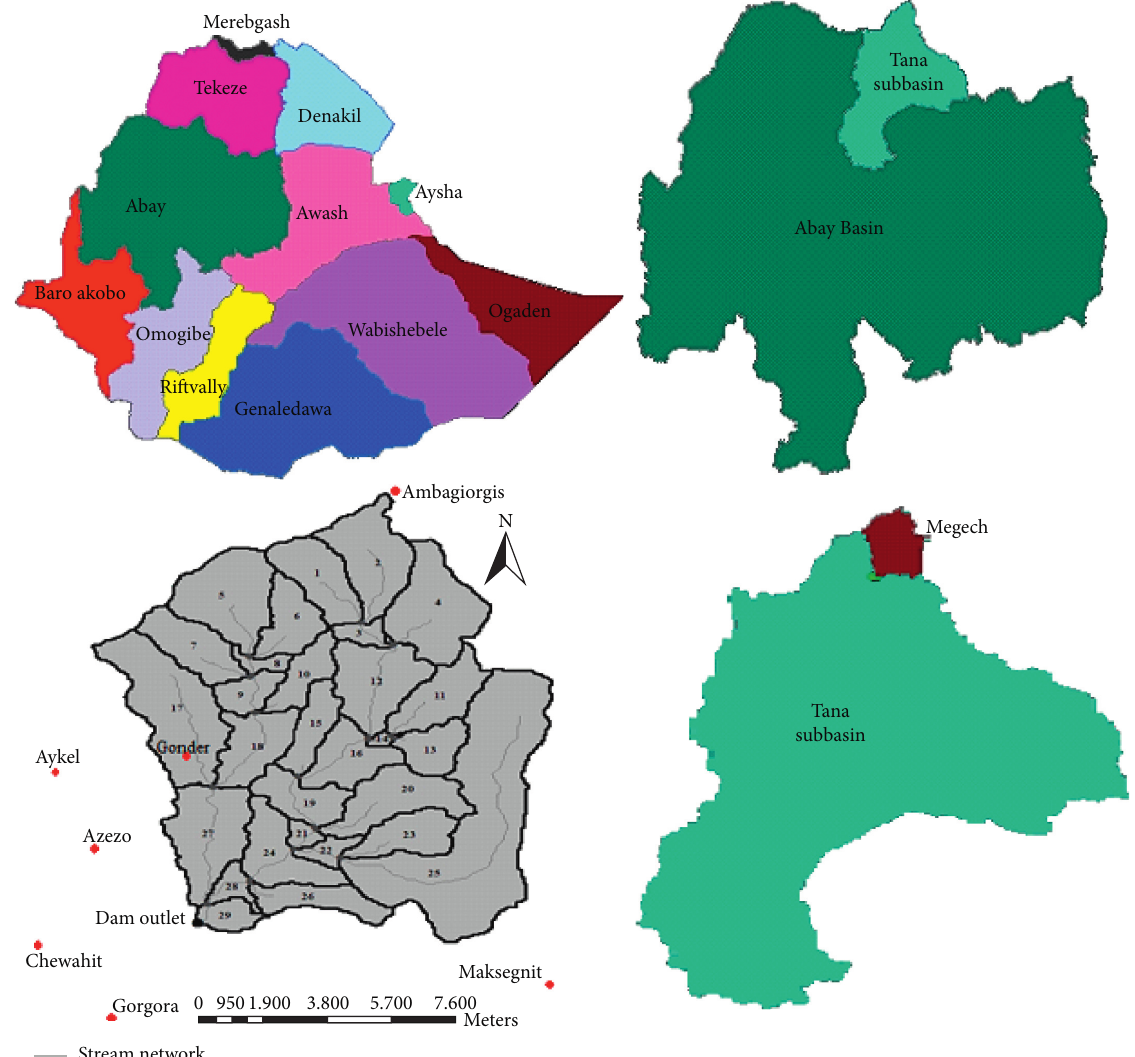
Figure 1: Location map of upper Megech dam